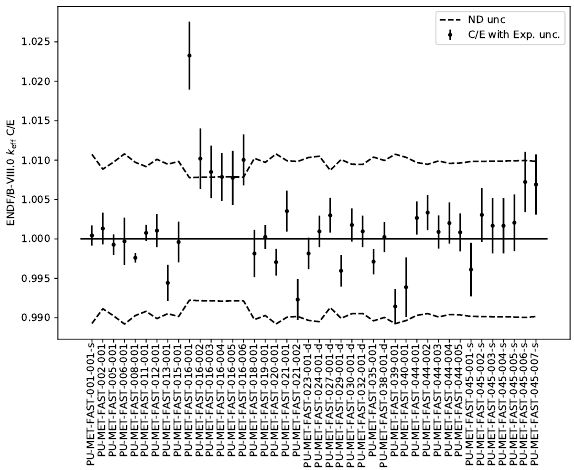
Figure 1. C / E values are shown for k e ff of PU-MET-FAST ICSBEP critical assemblies [16]. The solid, vertical lines are experimental uncertainties, while the dashed lines encompass Monte Carlo statistics, and uncertainties obtained by forward- propagating nuclear-data covariances via Eq. (1) in quadrature.